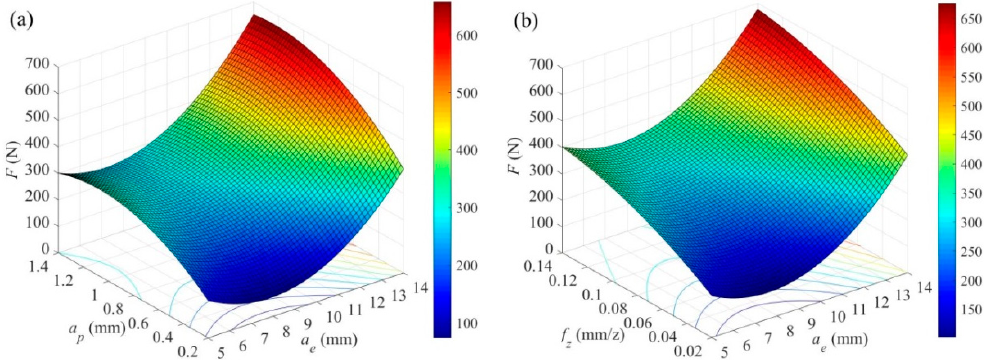
Figure 6. The interaction of ( a ) a e × a p ( V c = 80 m/min, f z = 0.06 mm/z), and ( b ) a e × f z ( V c = 80 m/min, a p = 0.6 mm) on maximum cutting force F .